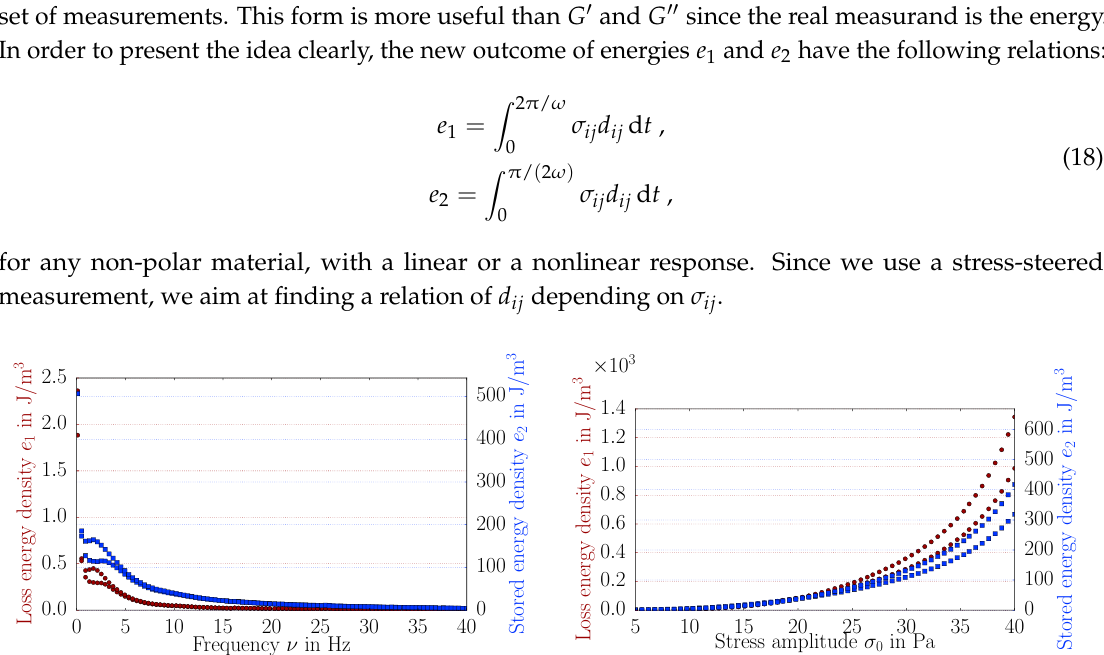
Figure 2. Loss (red circles) and stored (blue squares) energy densities obtained from the measurement: Left: Frequency variation by fixed amplitude, σ 0 = 40Pa. Right: Amplitude variation by fixed frequency, ν =